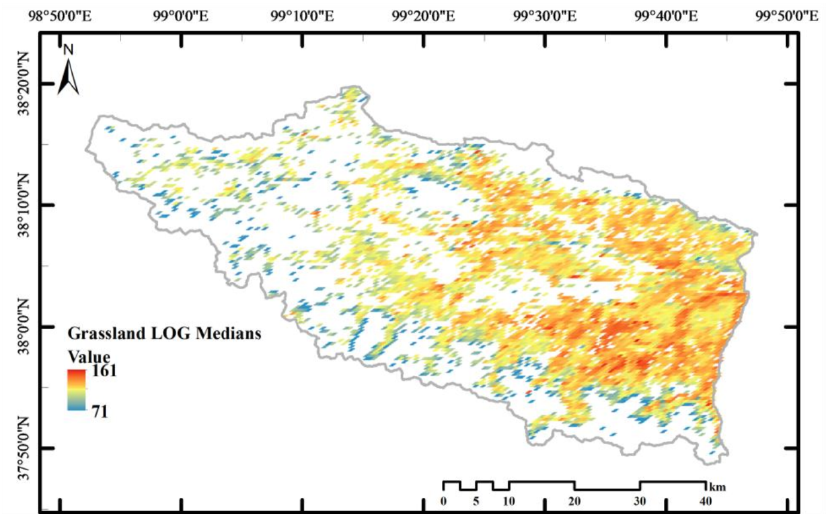
Figure 12. LOG average in the Muli region from 2014 to 2021.